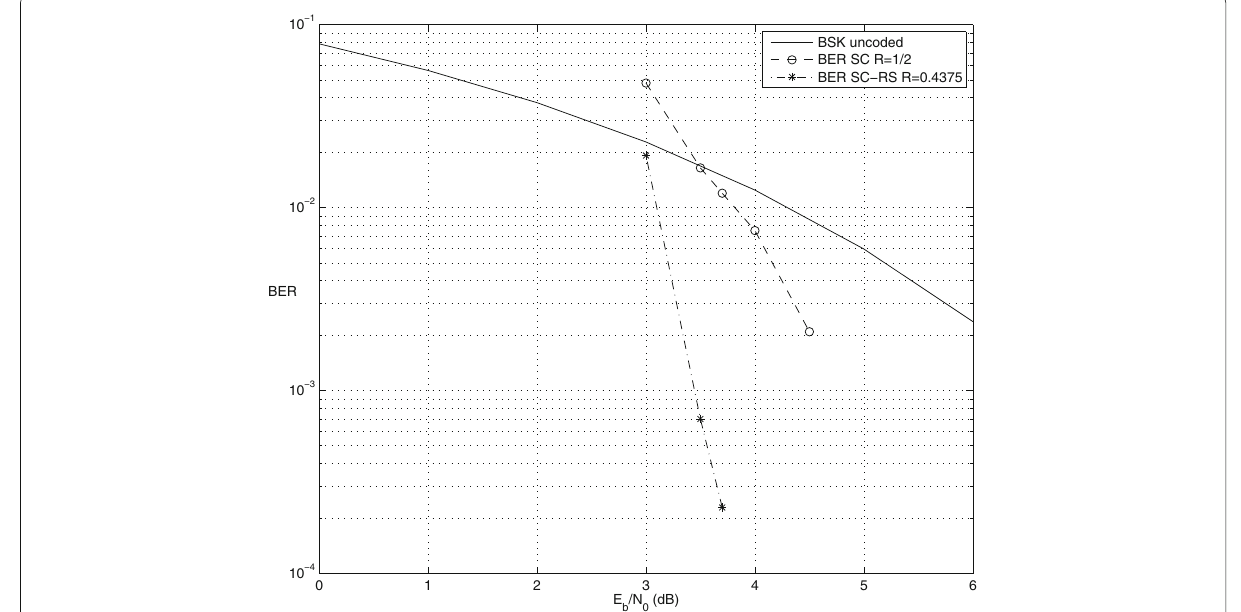
Fig. 3 BER versus E b for the uncoded, SC, and SC-RS architectures. The code rate is N 0